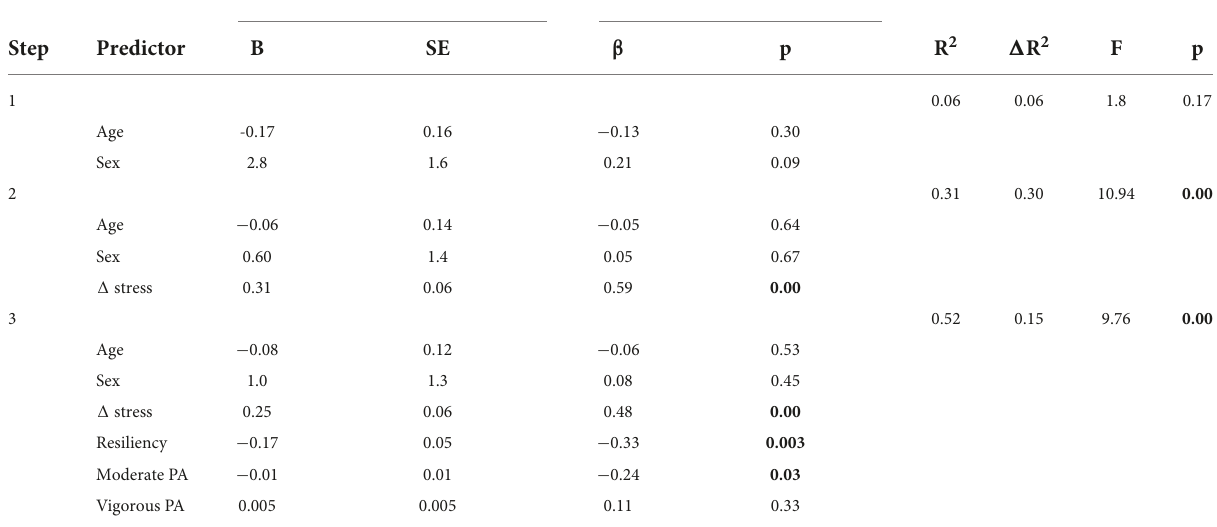
TABLE 4 Hierarchical regression coefficients: Anxiety.